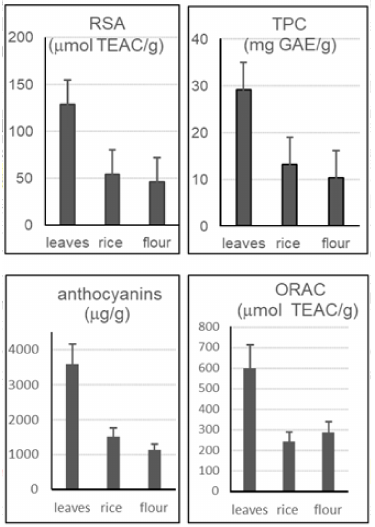
Figure 4. Comparison between ‘Violet Nori’ carypopses, flour, and leaves from the same year crop. Results are expressed on a ‘tel quel’